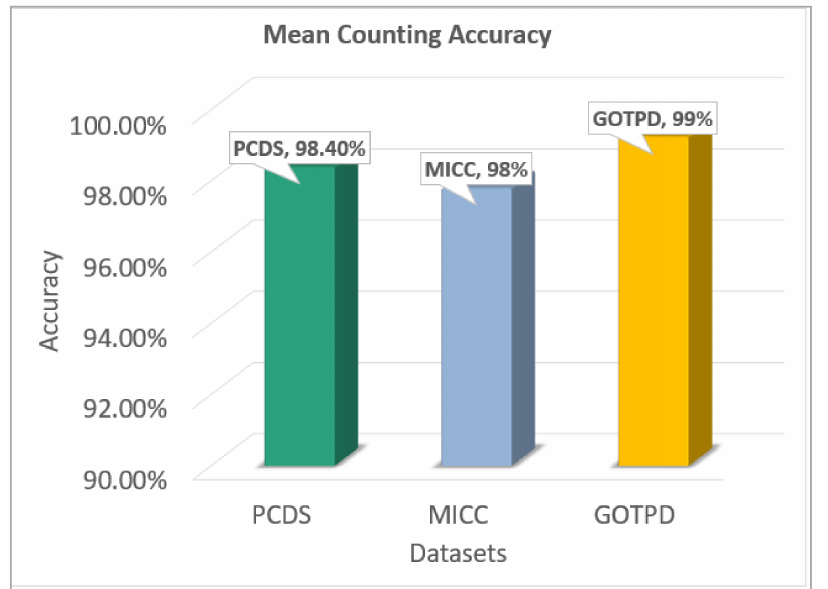
Figure 18. Accumulative head counting accuracies achieved on the three benchmark